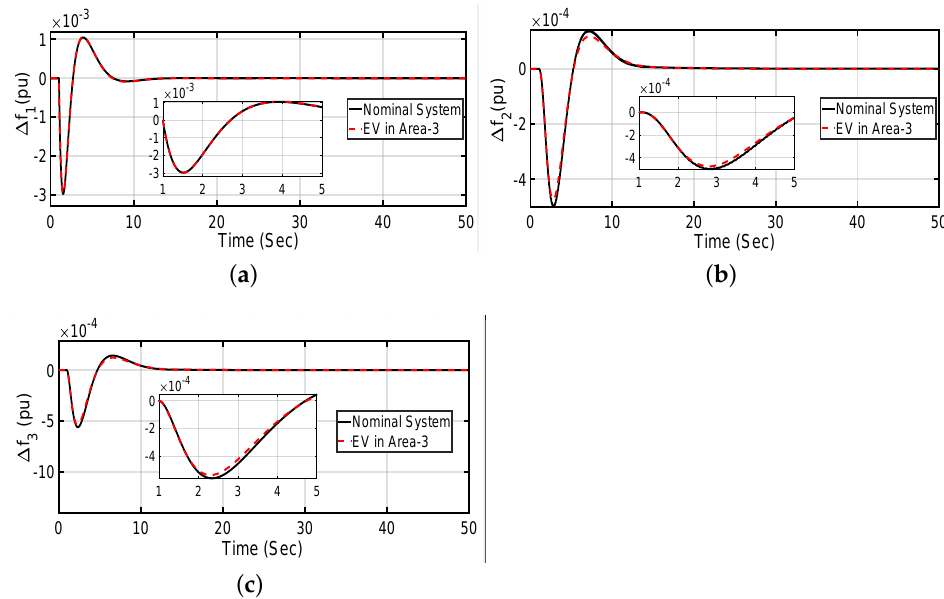
Figure 10. Response comparison when EVs are connected in Area 3 only. ( a ) ∆ f 1 ; ( b ) ∆ f 2 ; ( c ) ∆ f 3